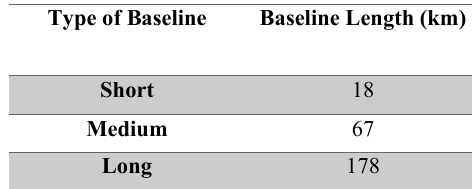
Table 1. Length for short, medium and long